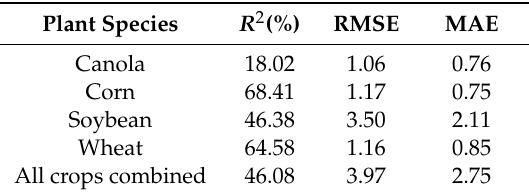
Table 3. Five-fold cross-validation results of water. The average of the metrics from the five folds is